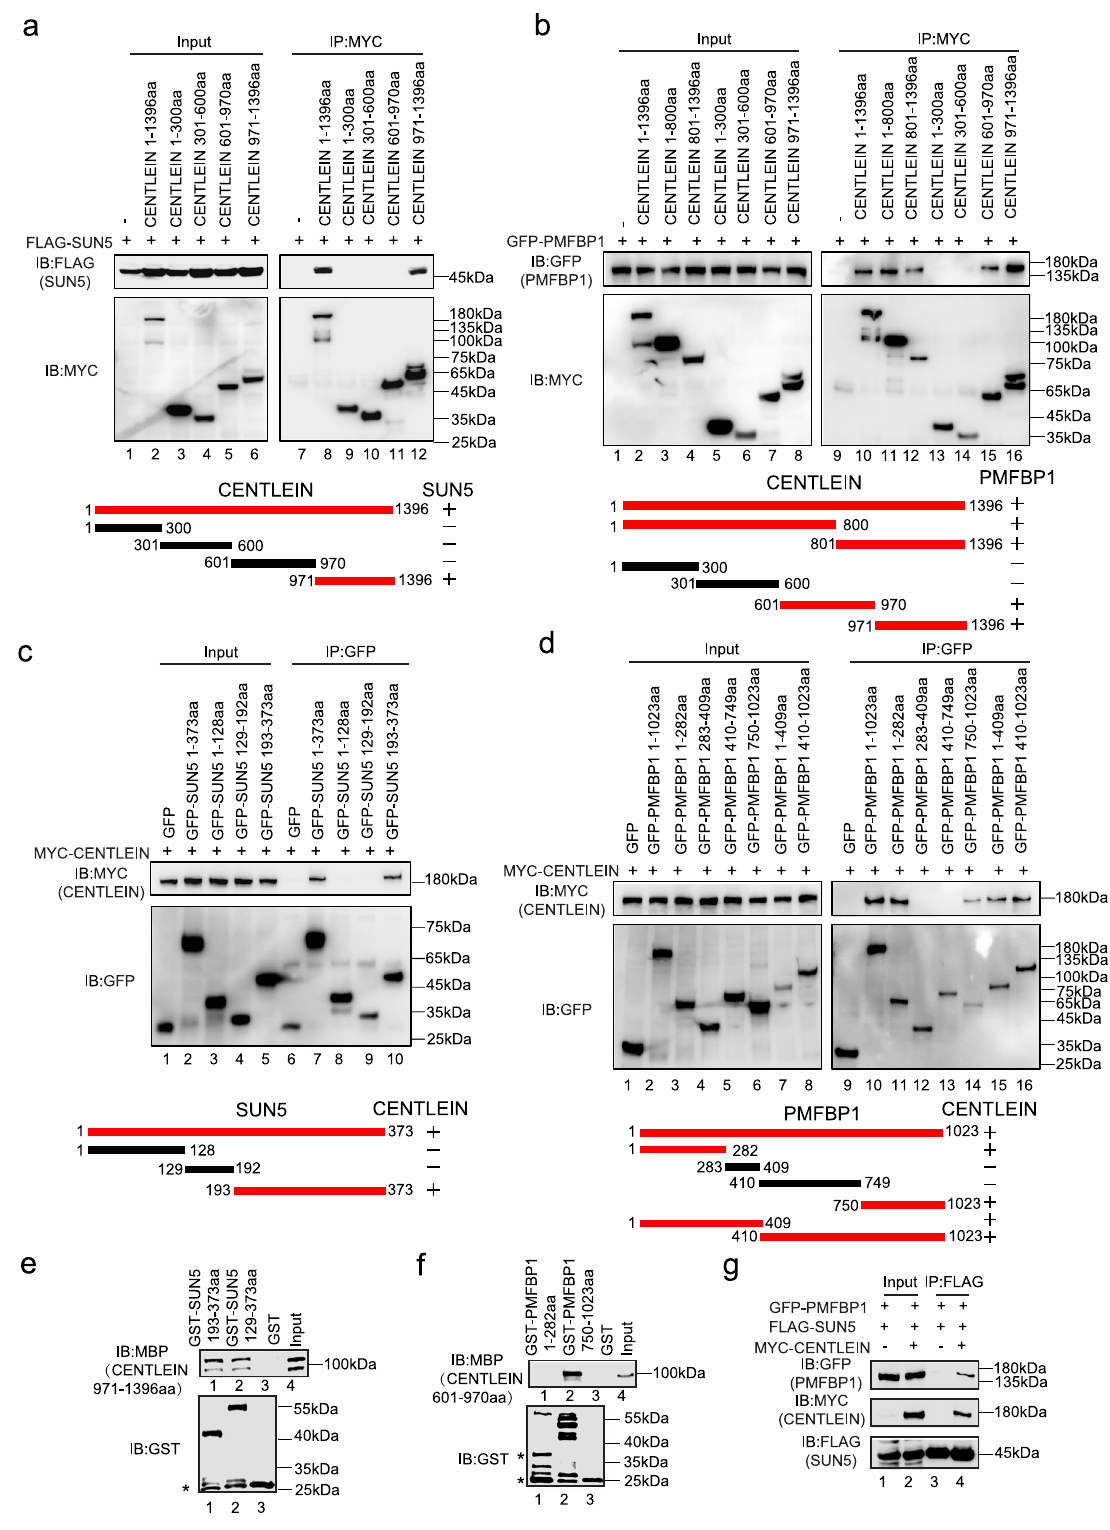
Plasmids . Sun5 and S pata6 were cloned into pRK-FLAG vector and P mfbp 1 was cloned into pEGFP-C1 vector 19 . Full-length mouse Centlein was obtained from mouse testis cDNA and cloned into the vectors pEGFP-C1 and pCMV-MYC. Centlein , Cep68 , Nek2a 37 , Bbs4 , Cp110 , Cpap , Cetn2 , and Plk1 were obtained from HeLa cell cDNA and cloned into the pEGFP-C1 vector using the Phanta ® Max Super-Fidelity DNA Polymerase (P505, Vazyme). The truncated mutants of Centlein were cloned into the vectors pCMV-MYC and pMAL-c2x using the Clon Express Ultra One Step Cloning Kit (C115, Vazyme). The truncated